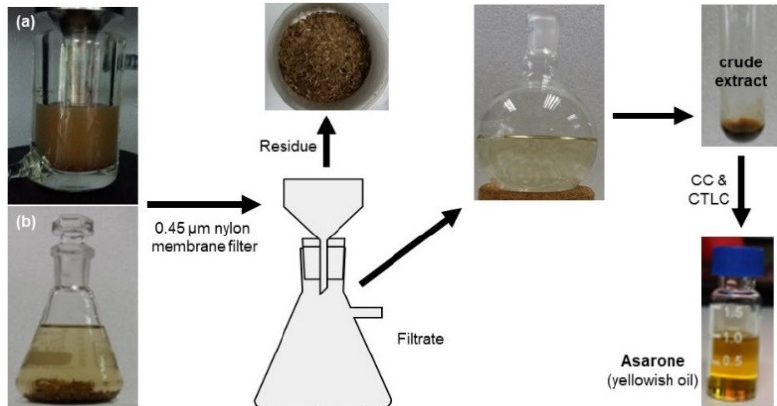
Figure 1. The ( a ) ultrasonic-assisted and ( b ) conventional solvent extraction processes in obtaining the pure asarone from A. calamus rhizome.